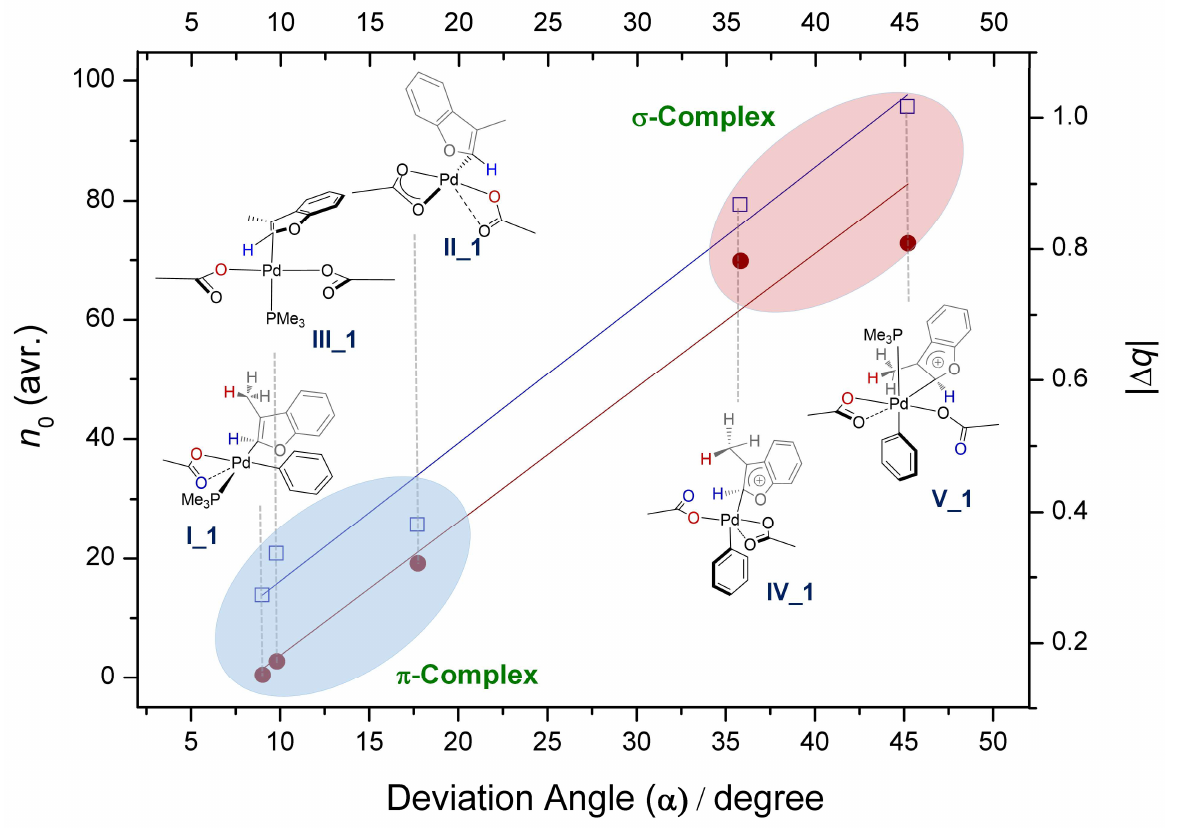
Figure 8. Correlation diagram of α vs. n 0 (avr.) (blue open square) and α vs. |Δ q | (dark red closed circle).